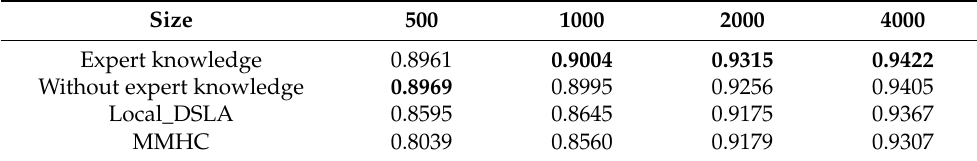
Table 8 simultaneously. Use bold fonts to mark the model method with the best reasoning performance under the condition of each dataset. Table 8. Diagnostic accuracy of different